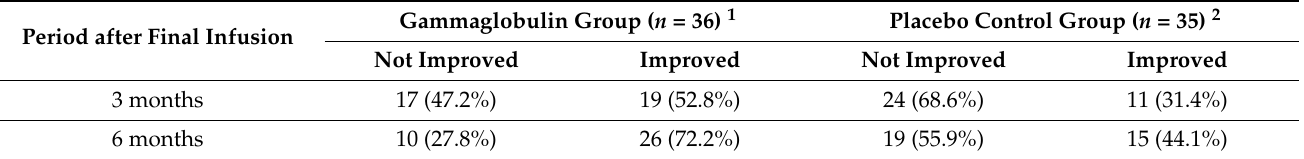
Table 3. Incidence of clinically significant improvement, Rowe 1997